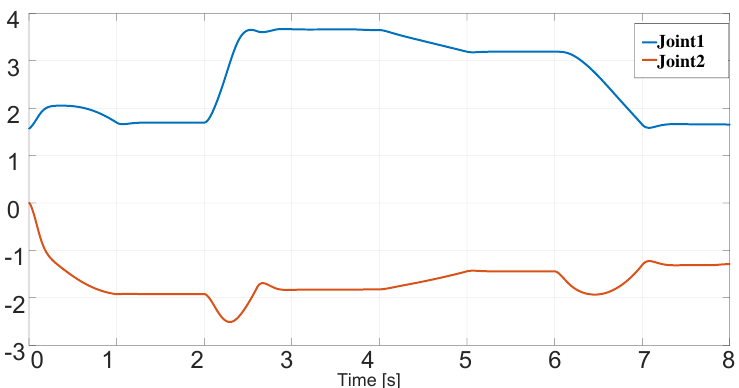
Figure 9. Dynamics controller outputs.